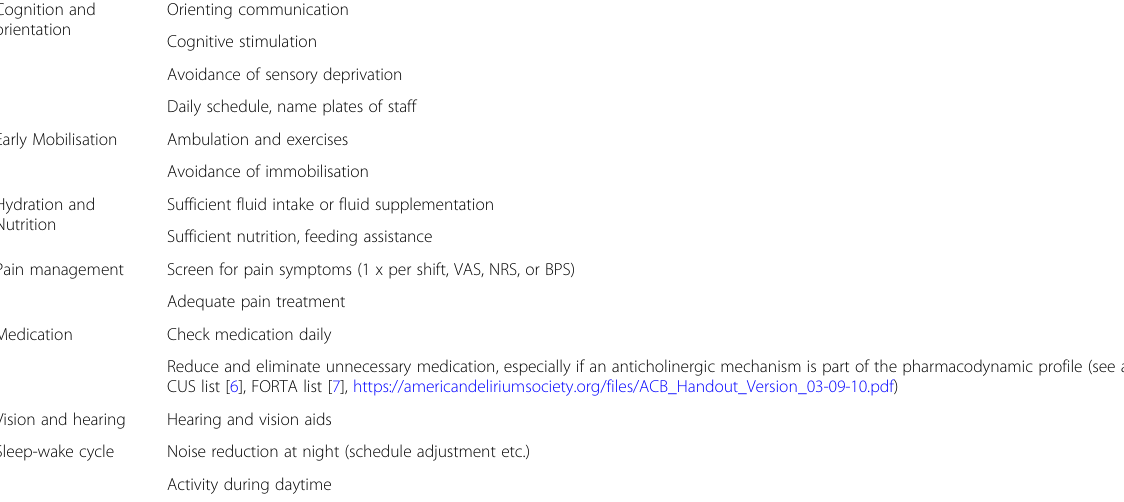
Table 1 Multi-component, non-pharmagological interventions to prevent and treat delirium Cognition and orientation